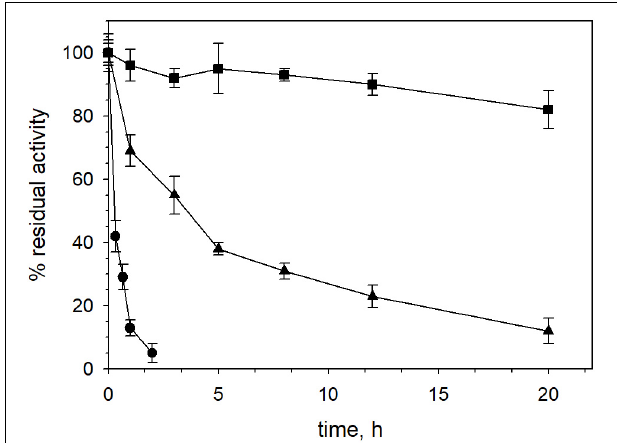
FIGURE 4 | XynDZ5 thermostability. The thermostability of XynDZ5 was evaluated by measuring residual activity following incubation of the enzyme at 65 ◦ C ( (cid:4) ), 70 ◦ C ( (cid:78) ), and 75 ◦ C ( • ) for up to 20 h. The reported values correspond to the mean value from three independent experiments performed in triplicate ±